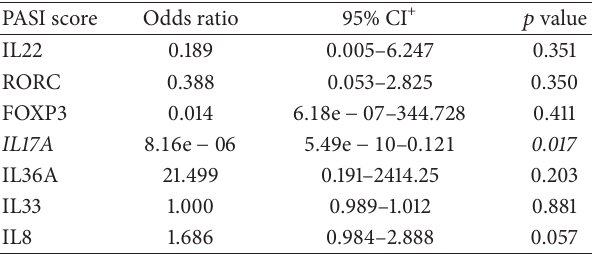
a CI + : confidence